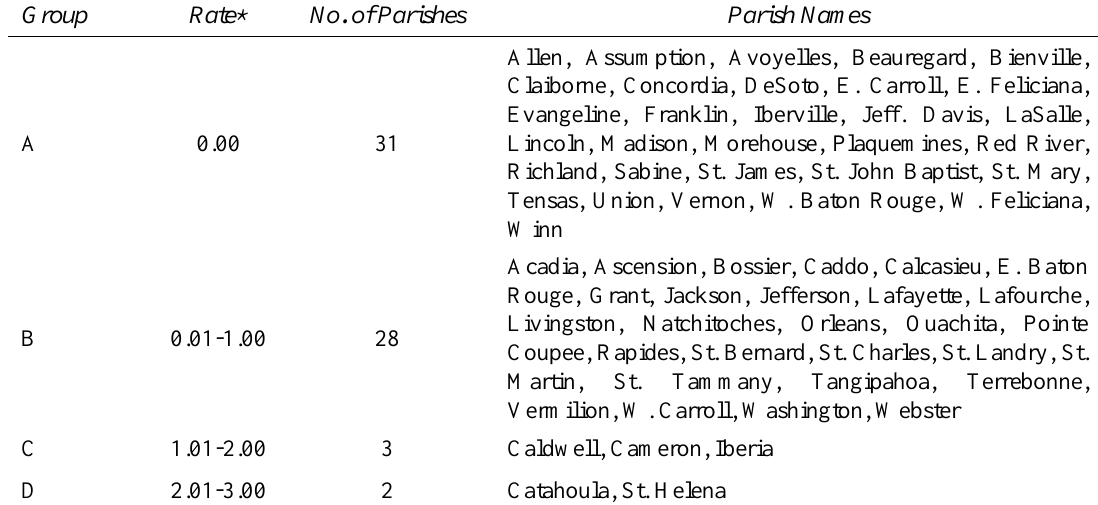
Table 5: Distribution of campylobacter in various parishes for the year 2000.